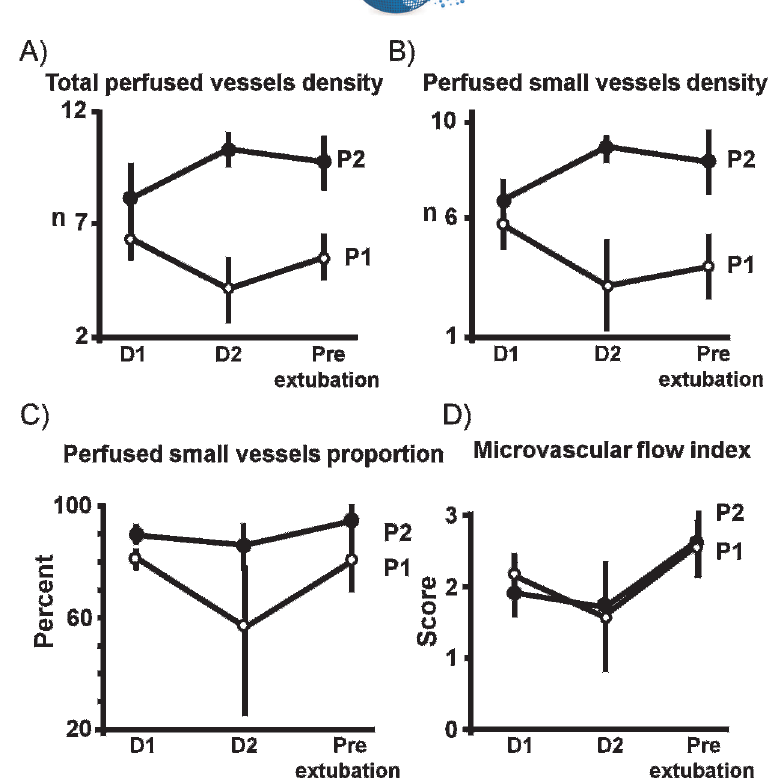
Figure 1 - The evolution of microcirculatory analysis. The measurements were performed on the first and second days and on the day prior to extubation. A) Number of perfused vessels. The number of perfused vessels that cross the horizontal and vertical equidistant lines drawn on the screen divided by the total length of the lines, according to the De Backer score. B) Number of perfused small vessels. The number of perfused small vessels ( , 20 m m) that cross the horizontal and vertical equidistant lines drawn on the screen divided by the total length of the lines, according to the De Backer score. C) The proportion of perfused small vessels can be calculated as follows: 100 x (total number of vessels - [no flow vessels + intermittent flow vessels])/total number of vessels. D) Microvascular flow index based on the predominant flow in the four screen quadrants. The flow is characterized as absent (0), intermittent (1), sluggish (2), or normal (3). The final result is the average of the four quadrants.